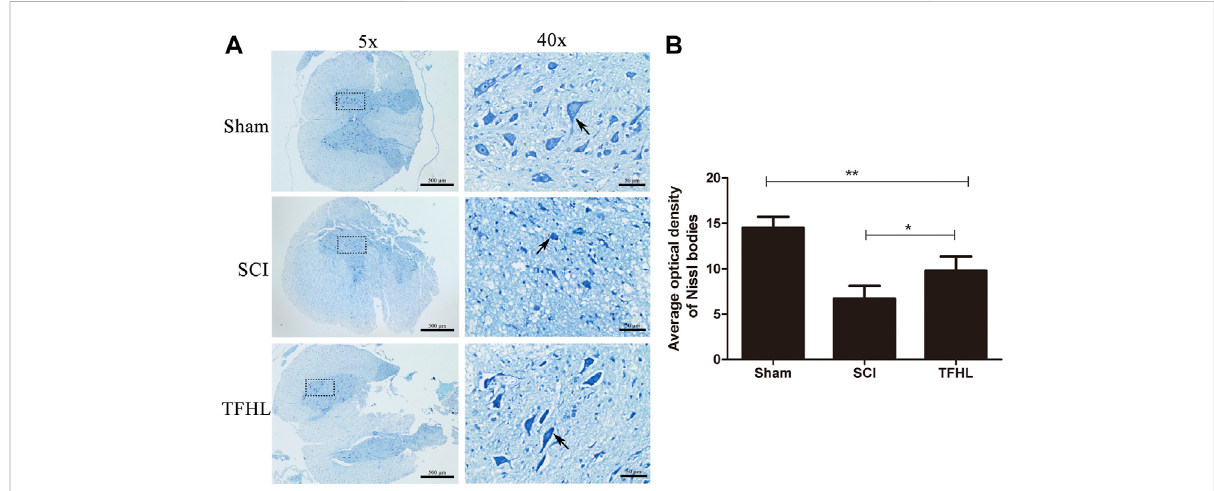
FIGURE 5 TFHL improves functional status of neurons in injured spinal cord tissues. (A) Observation of Nissl bodies in neurons of spinal cord tissues of eachgroupbyNisslstaining( n =3,cross-sectionoftheT10segmentofspinalcord,scalebars:500and50 μ M).BluestainingrepresentsaNisslbody, as shown by the arrows. The darker the color of the Nissl bodies or the tabby shape, the better the neuron state. The black dashed box in the ×5 magni fi cation is the observation site under ×40 magni fi cation. (B) The average optical density of Nissl bodies in spinal cord tissues of eachgroup. Noticetheincreaseinaverageopticaldensity ofNisslbodiesintheTFHLgroupcomparedtotheSCIgroup.Alldataareexpressedasthe mean ± SD. Differences among groups were determined with one-way ANOVA followed by a least-signi fi cant difference post hoc test. * p < 0.05, ** p < 0.01, *** p < 0.001.